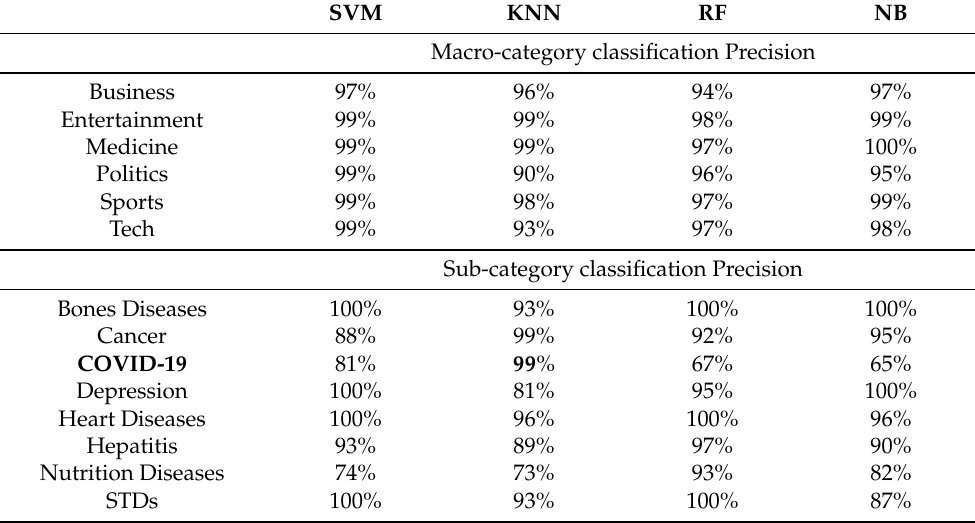
Table 1. Precision for the macro-category (top) and sub-category (bottom) classification on the validation